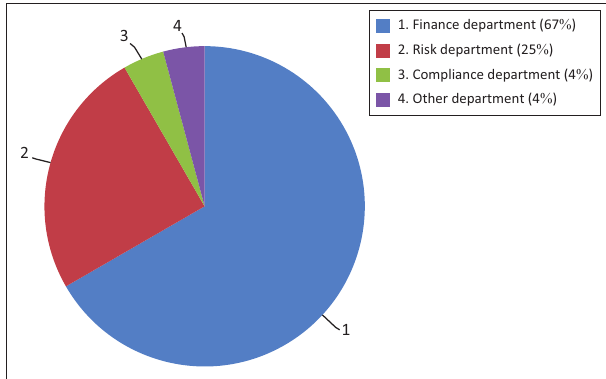
FIG URE 6: Responsibility for calculations.